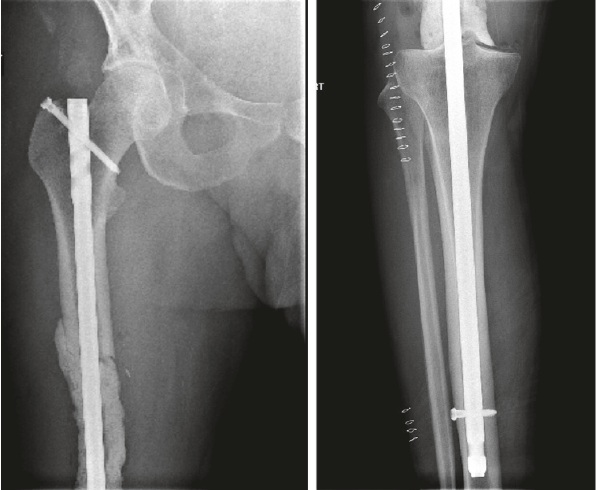
Figure 3: Postoperative AP radiographs showing long nail with surrounding cement.